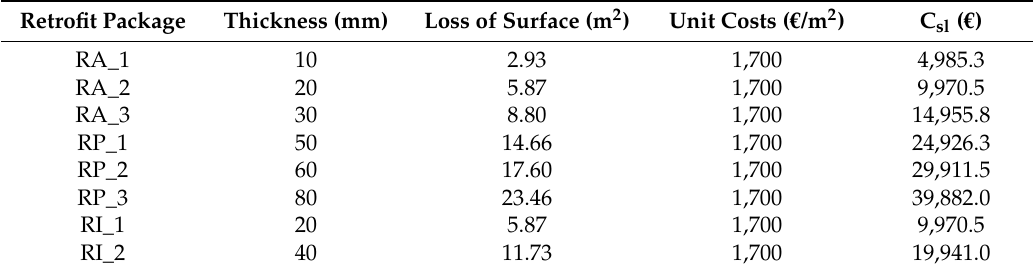
Table 5. Proposed retrofit packages: indirect costs C sl due to the loss of useful floor surface. Retrofit Package Thickness